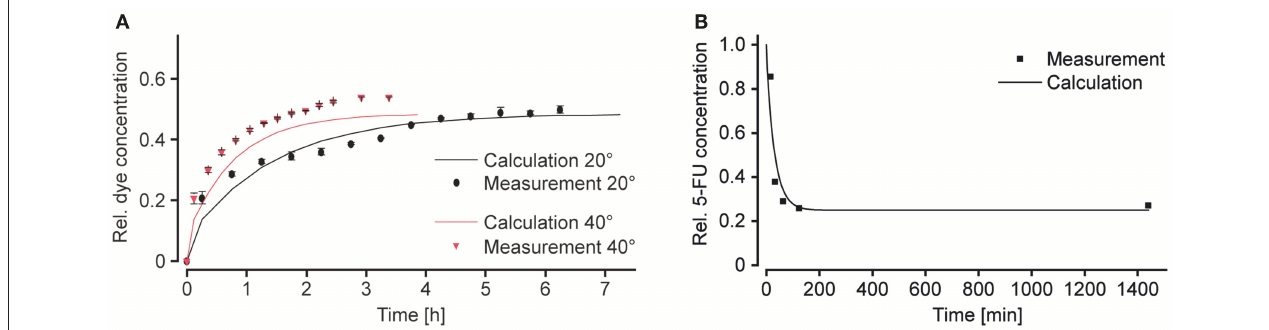
FIGURE 5 | Modulation of the substance concentration profile. (A) Amaranth red dye was used to simulate and track substance concentrations in the chip over time. Changing the tilting angle α modulates the slope of the concentration curve ( V S / V M = 1; R S / R M = 4; n = 3 chips). (B) Decreasing concentration of 5-fluorouracil (5-FU) in the main channel over time. Peak area and concentration measurements were done by means of ultra-performance liquid chromatography, coupled to mass spectrometry UPLC-MS ( V S / V M = 0.66; R S / R M > 0.25; α = 20 ◦ ; n = 1